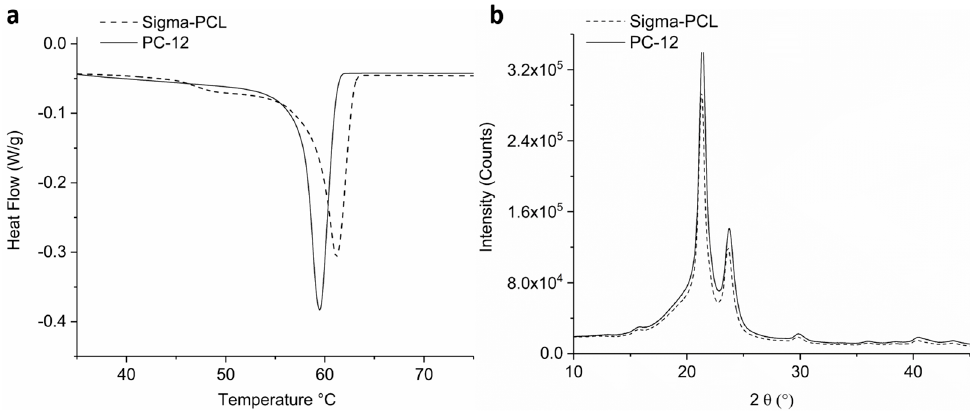
Figure 5. Exemplary graphs of ( a ) DSC heat flow curves and ( b ) XRD profiles of PCL tubes with 100 µm wall thickness.